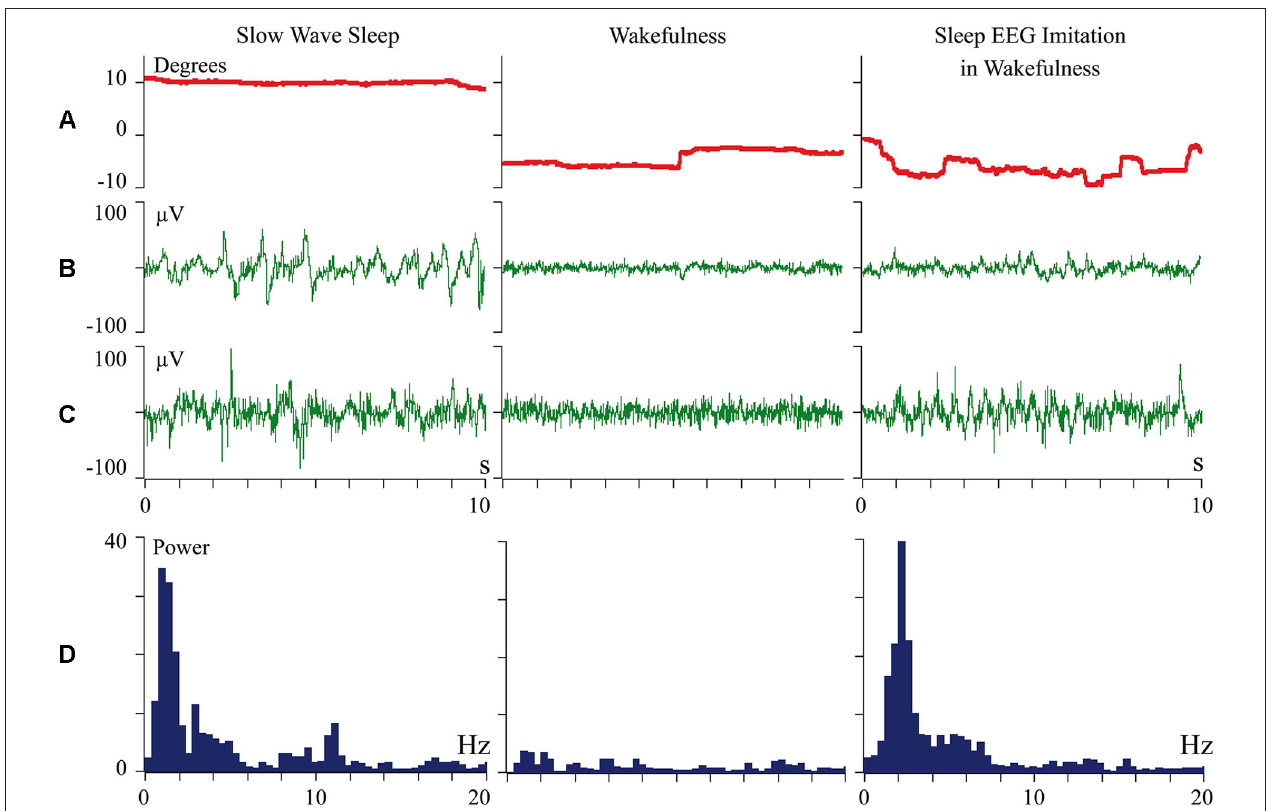
from another within the cortical somatosensory area 5; (D) power spectrum of the local EEG presented above in panel C . All parameters were collected during SWS (left column), during passive wakefulness (middle column) and during the procedure of “sleep EEG imitation” in wakefulness by rhythmic stimulation of the contralateral forepaw, which produced strong excitation of the cortical neurons recorded by the microelectrodes. Technical details of the study in Pigarev et al.